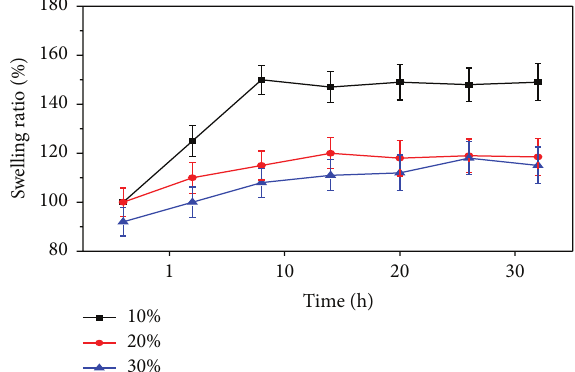
Figure 11: Effect of bioglass on swelling behaviour of GCB compos- ite scaffolds as a function of